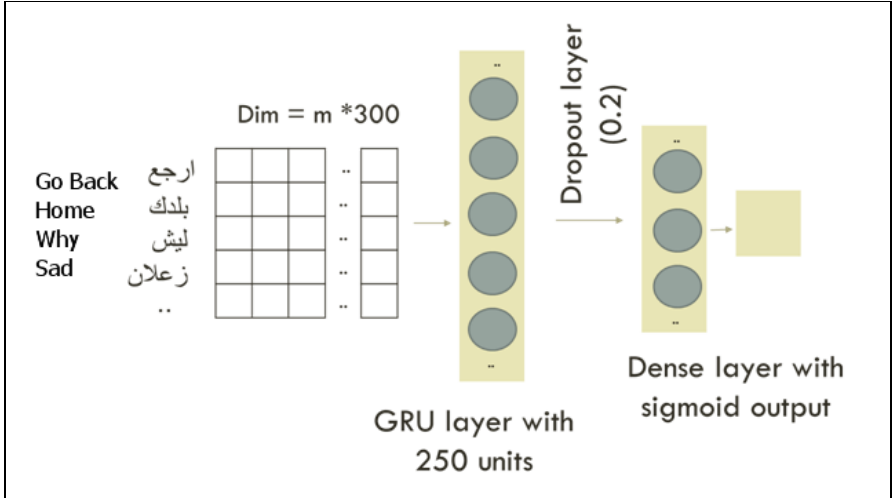
Figure 2. Gated recurrent unit (GRU) architecture .